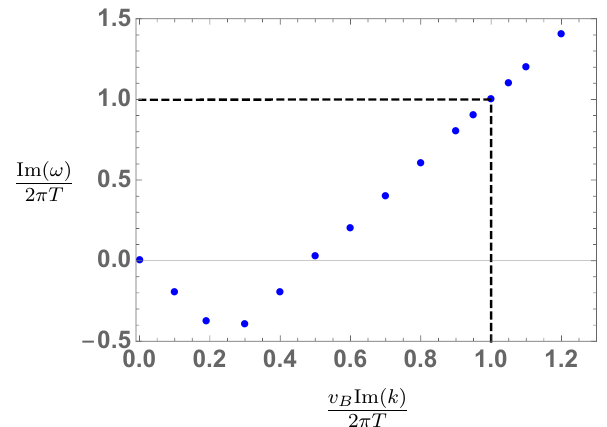
Figure 4 . Sound channel quasinormal modes of the hyperbolic black hole de(cid:12)ned in (4.5). The blue dots represent the zeros of a ( !; k ) in (4.1). They form a line that passes though the special point ( ! ? ; k ? ) = i (2 (cid:25)T; 2 (cid:25)T=v B ) with v B given in (4.18). Here, k := (cid:0) iL=‘ , and we set z 0 = 1. For simplicity, we used the asymptotic form of the Legendre functions in the ansatz for the metric per-